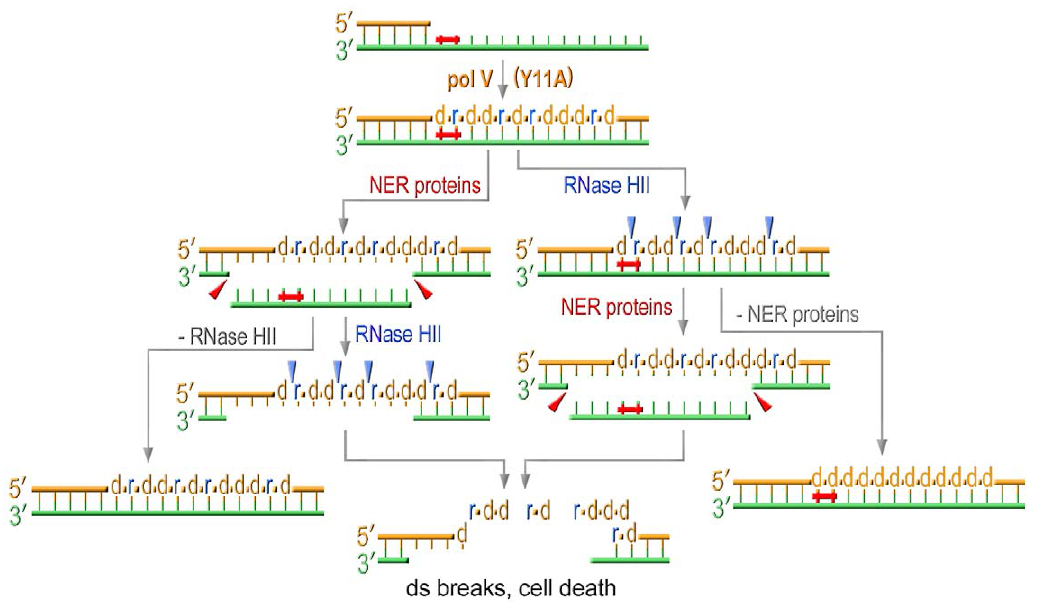
Figure 6. Model for the effect of RNase HII and NER proteins on UV sensitivity of strains proficient for ribonucleotide incorporation. Translesion replication catalyzed by Y11A mutant produces a TLS tract containing multiple ribonucleotides. NER excises UV-induced lesions and produces gaps on the template strand. RNase HII initiating removal of multiple rNMPs incorporated during TLS produces nicks on the daughter strand. The concerted action of both these repair pathways results in formation of persistent double strand breaks ultimately leading to cell death. Inactivation of either repair pathway selectively improves UV-resistance of cells expressing UmuC_Y11A.